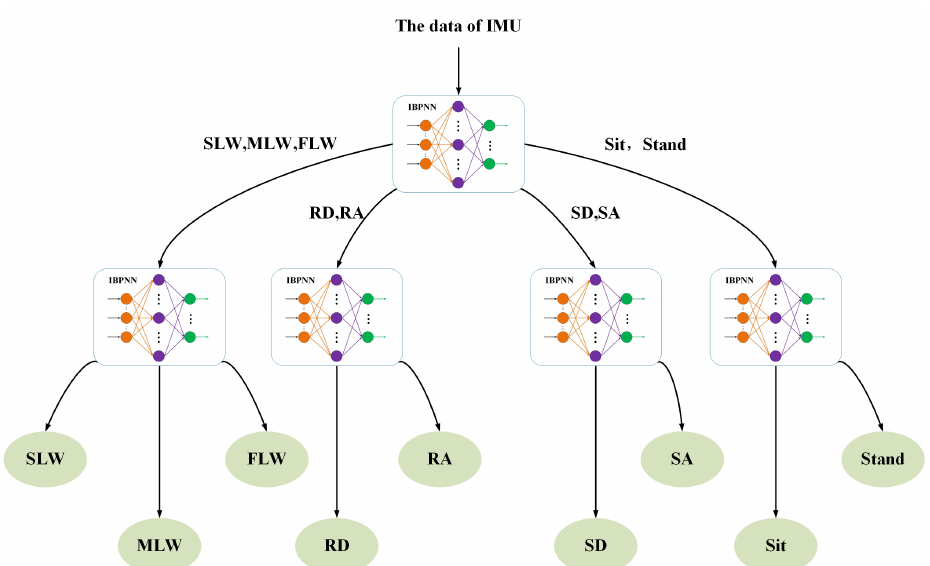
Figure 1. Decision tree structure (DTS) A: two layers and five judgment nodes based on locomotion mode data.